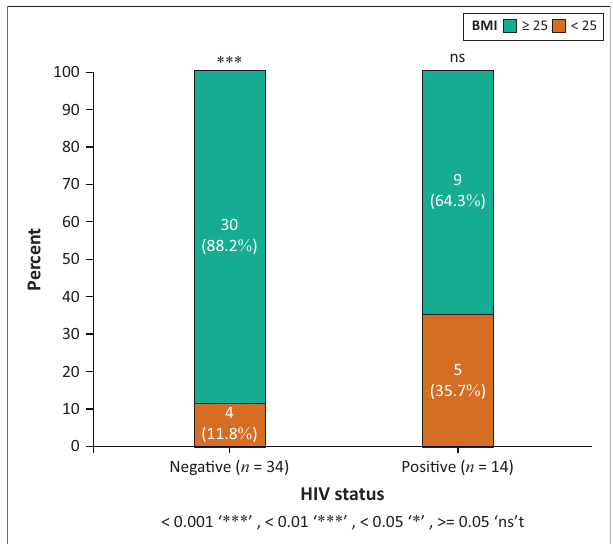
FIGURE 2: Body mass index comparison of human immunodeficiency virus- negative and women living with human immunodeficiency virus patients in the normal (< 25), overweight/obese (> 25)